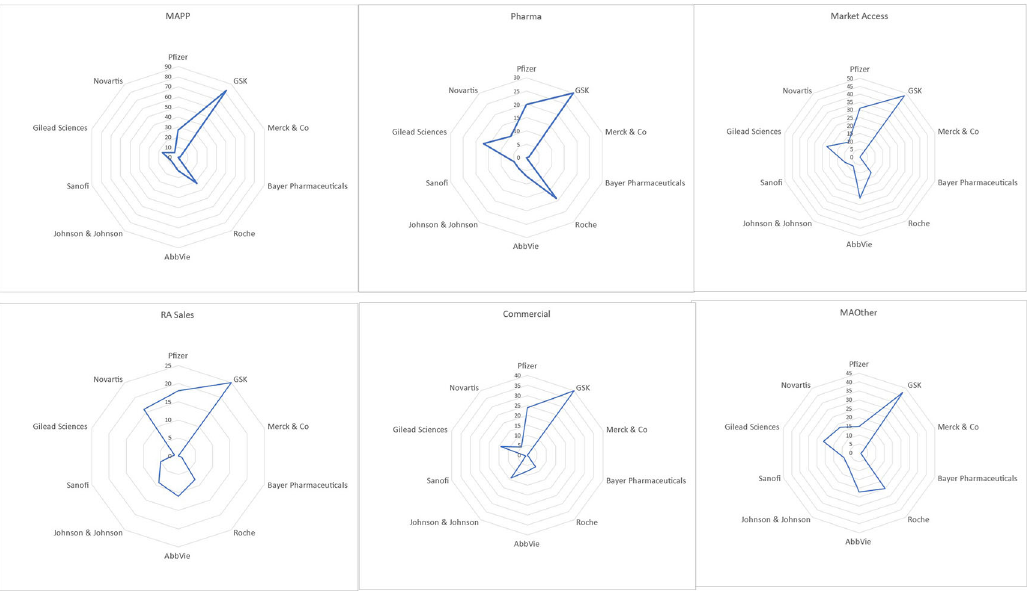
Figure 1. Number of internal stakeholders in each group from the 10 pharmaceutical companies with the highest market share in the UK at the time of